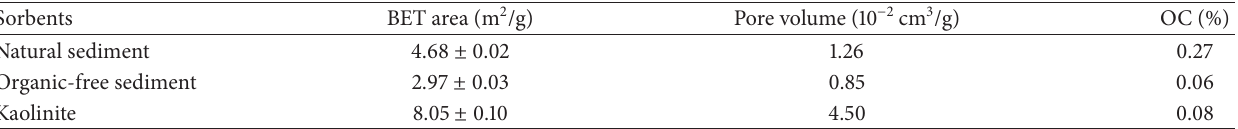
Table 1: Properties of the